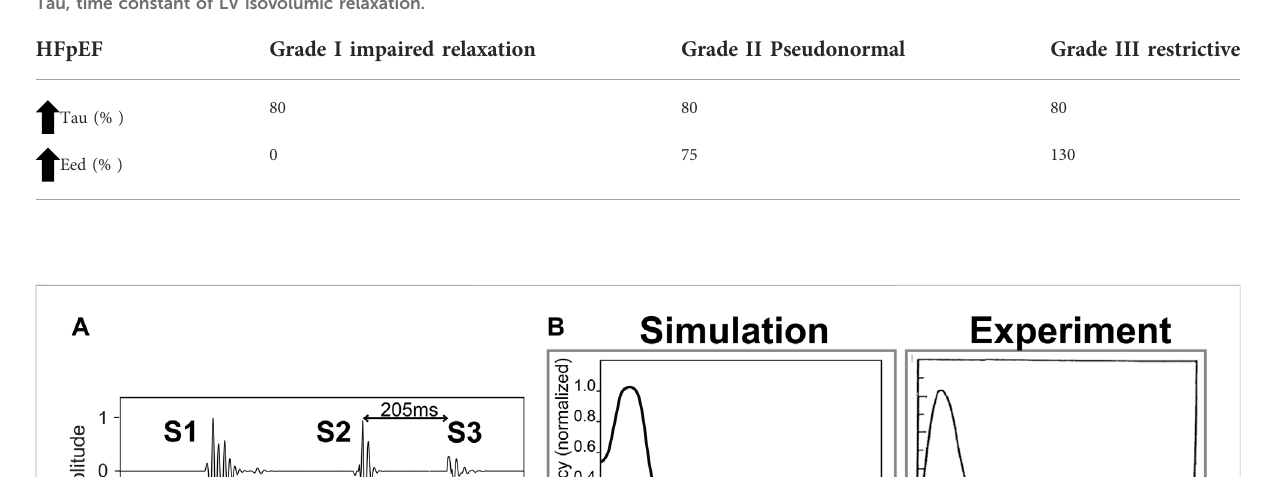
TABLE 1 Simulation protocol for three severity levels of HFpEF. HFpEF, heart failure with preserved ejection fraction; Eed, end-diastolic elastance; Tau, time constant of LV isovolumic